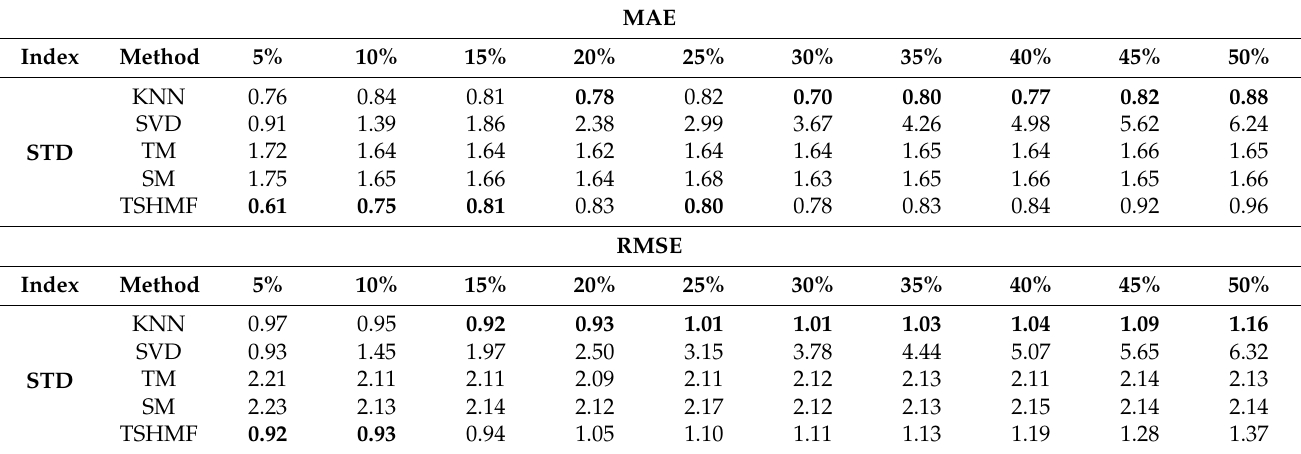
Table 1. Descriptive statistics in random missing scenario of all methods.